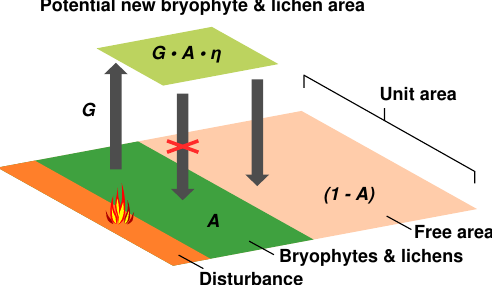
Figure 1. Change in surface coverage A of bryophytes and lichens. A is reduced by disturbance and increases due to net growth G . New bryophyte and lichen cover per unit area is limited by the generat- ing area A , the expansion efficiency η and the available free area (1 − A